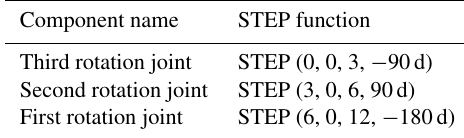
motion pairs between the specific components are shown in Fig. 18.